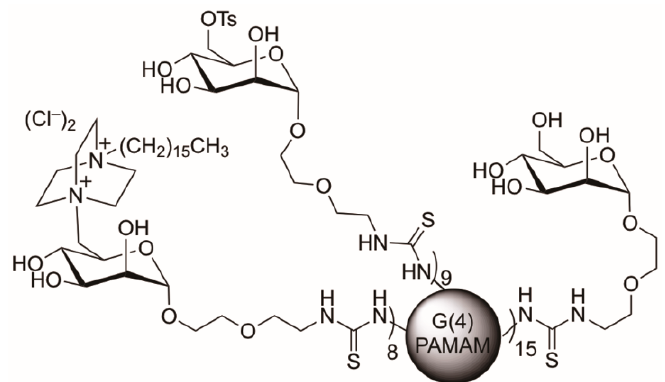
Figure 1. C 16 -DABCO Mannose Functionalized Dendrimer (DABCOMD) Structure.